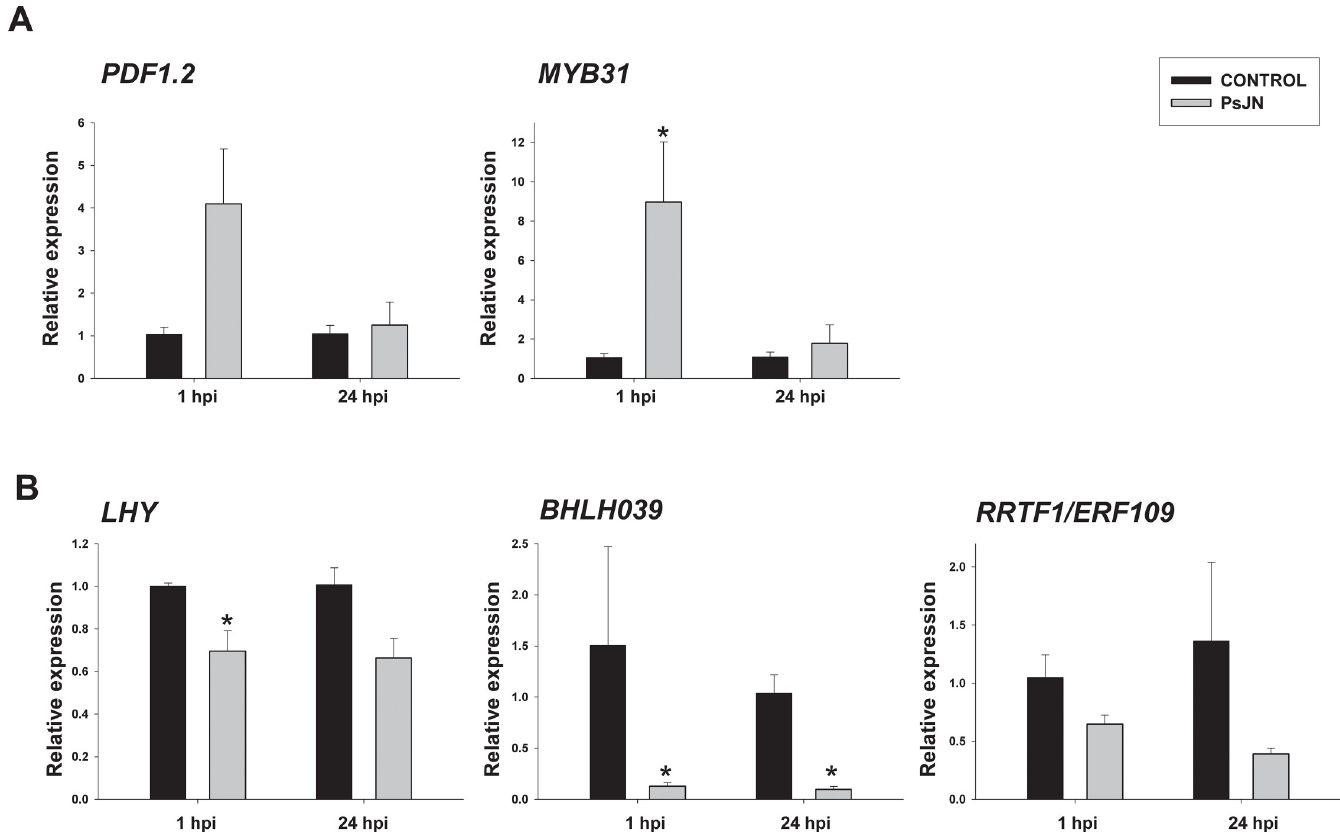
Fig 6. Temporal quantitative real-time PCR of selected transcription factors-coding genes and PDF1 . 2 in Arabidopsis in response to Paraburkholderia phytofirmans PsJN inoculation after a challenge with Pseudomonas syringae DC3000 strain. Relative gene expression of selected genes at 1 and 24 hours post infection (hpi) with strain Pst DC3000 in plants that were inoculated (gray bars) or not (control, black bars) with strain PsJN. Genes with an up-regulated pattern at 1 hpi are shown in (A). Those with a down-regulated pattern at 1 hpi are shown in (B). Data are means ± SE of three biological replicates per treatment and two technical replicates. Normalization was performed with the housekeeping TIP4 gene. Asterisk indicates statistical significance among treatments in a particular time (One way ANOVA, p <